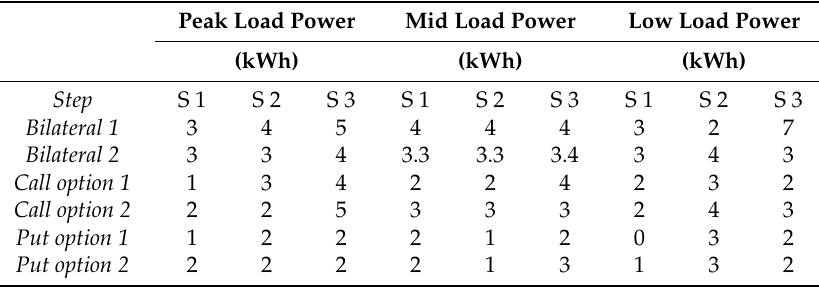
Table 8. Data of contracts’ offered power